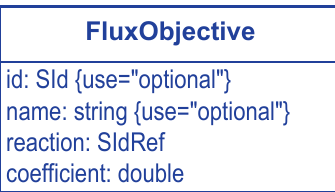
The id and name